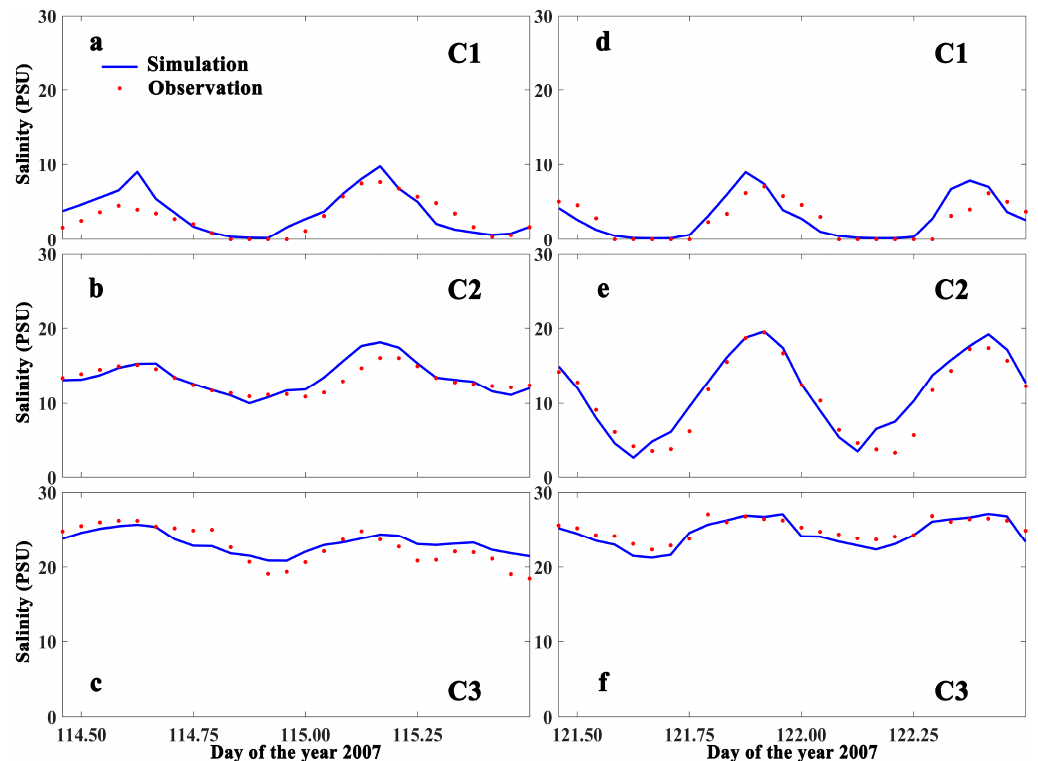
Figure 4. Observed (dot red line) and simulated (solid blue line) vertical averaged current velocity and current direction during neap tide ( a – c current velocity in m·s − 1 ; d – f current direction in degree) and spring tide ( g – i current velocity in m·s − 1 ; j – l current direction in degree) at the C1~C3 stations.